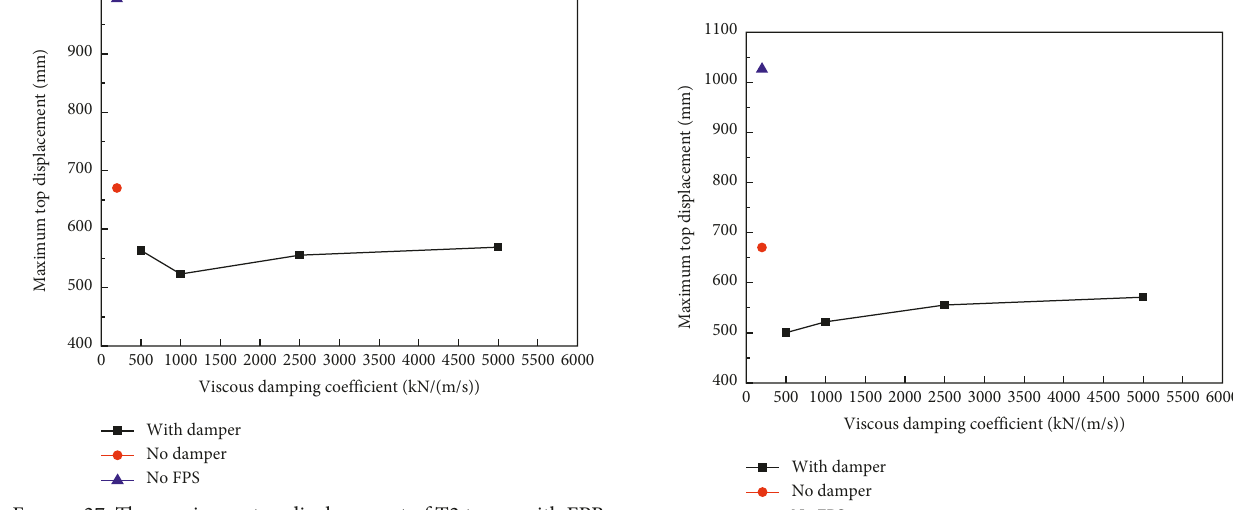
Figure 27: The maximum top displacement of T2 tower with FPBs ( R d 4500, μ 0 . 02) and varying viscous damping coefficients in (cid:31) (cid:31) the X direction under L0689S wave.